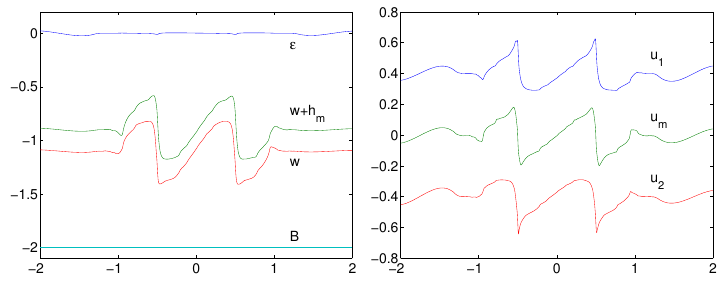
Figure 6. Example 1: Solution of the three-layer system with (cid:98) h m = 0 . 2.